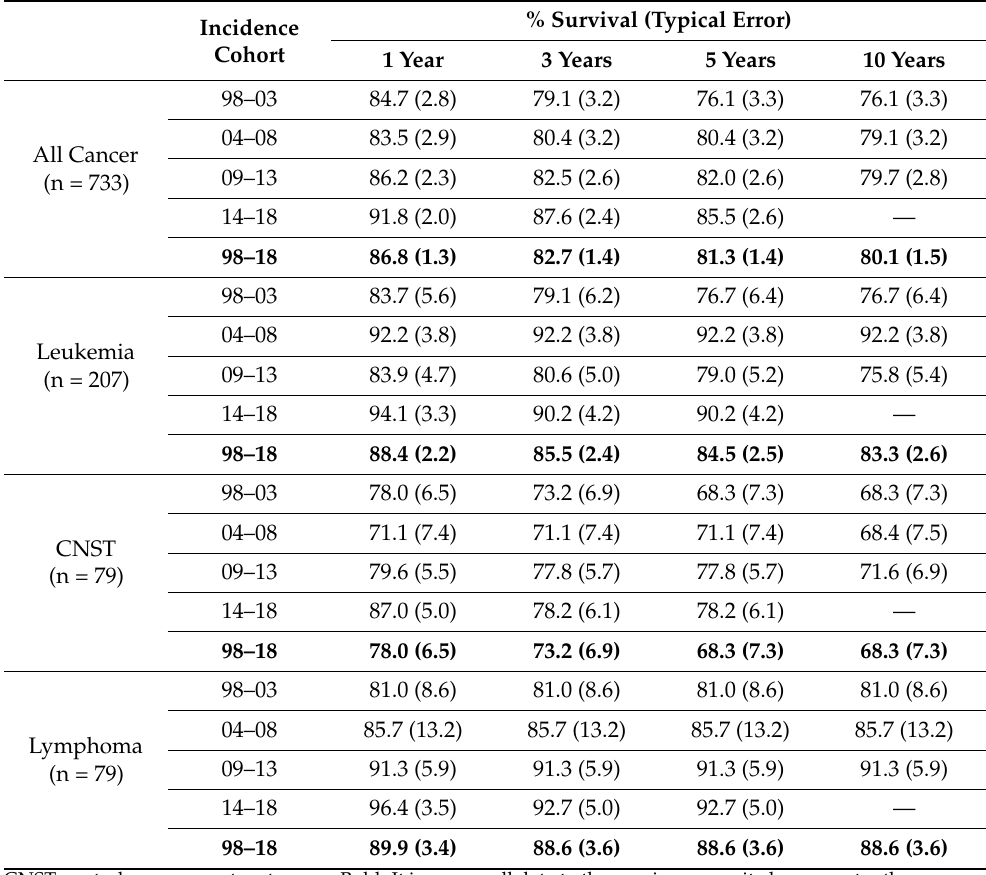
Table 4. Childhood cancer survival at 1, 3, 5, and 10 years after diagnosis by common tumor type and incidence during four time periods in the region of Murcia